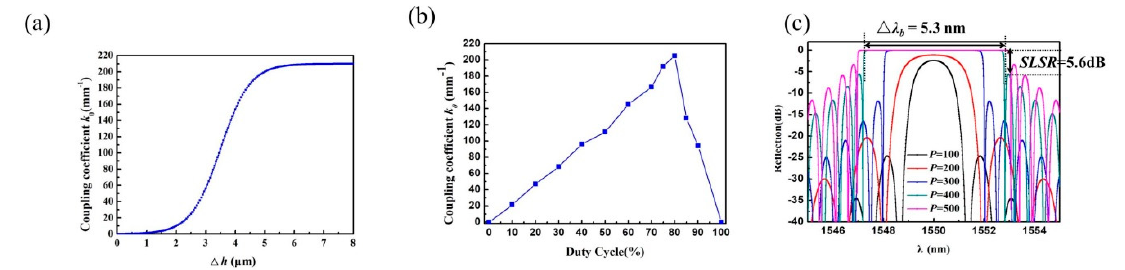
Figure 4. ( a ) Relationship between ∆ h and k 0 ; ( b ) Relationship between Duty and k 0 ; ( c ) Reflection spectrum at di ff erent grating lengths ( P = 100, 200, 300, 400 and 500 µ m).